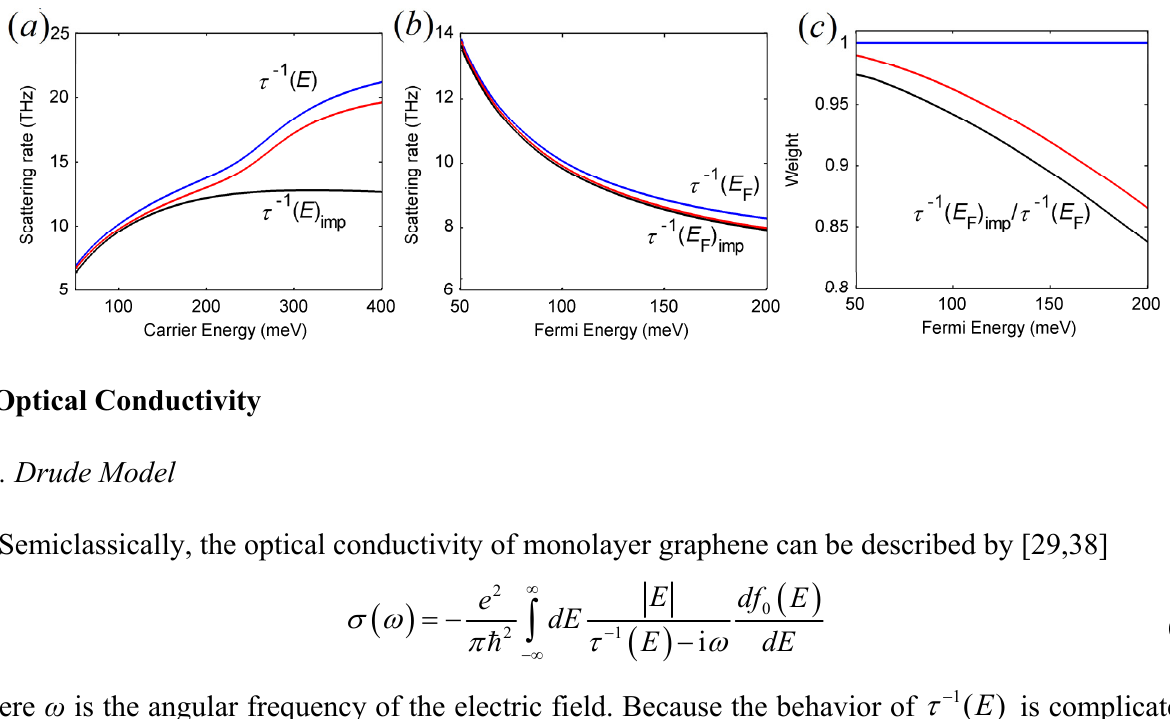
Figure 1. Scattering rate of carriers in graphene as a function of ( a ) the carrier energy; and ( b ) the Fermi energy. Curves from top to bottom: the total scattering rate (blue curves), (red curves), and (black curves). Curves plotted in ( c ) are scattering rates plotted in ( b ) but normalized to the total scattering